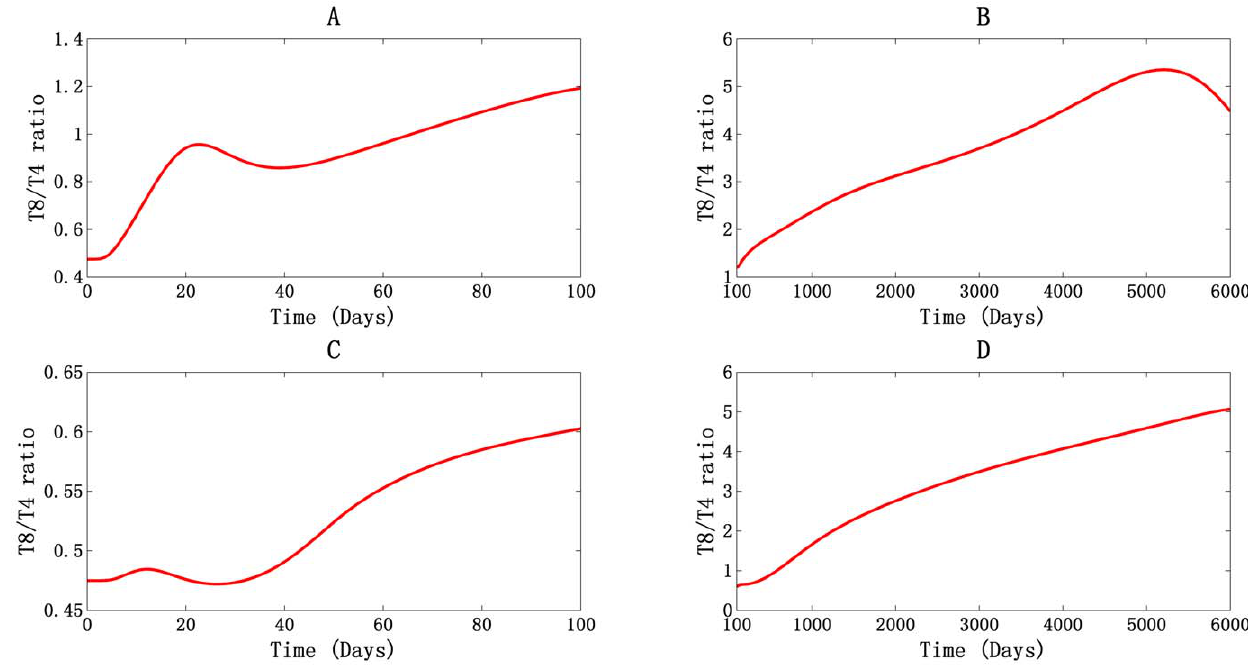
Figure 2. The T8/T4 ratio. Changes in the T8/T4 ratio change in PB (A and B) and LNs (C and D), during the first 100 days (A and C) and from day 100 to day 6000 (B and